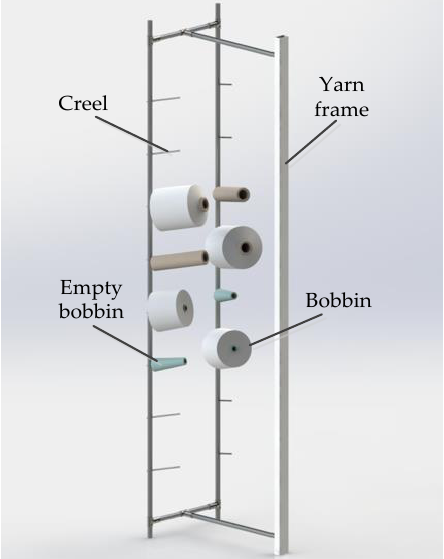
Figure 1. The structure diagram of the commonly used floor